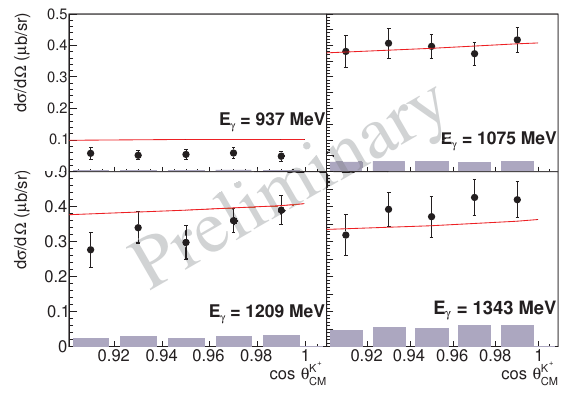
Figure 17. γ p → K + Λ di ff erential cross section for four example . Systematic photon beam energies (labelled inset) versus cos K + CM errors are the filled grey bars on the abscissa. The red line is the Bonn-Gatchina PWA solution